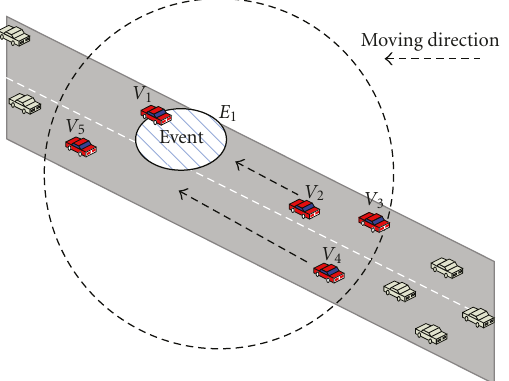
Figure 2: A vehicle ( V 1 ) encounters a tra ffi c event ( E 1 ) and transmits the tra ffi c warning message to other vehicles.